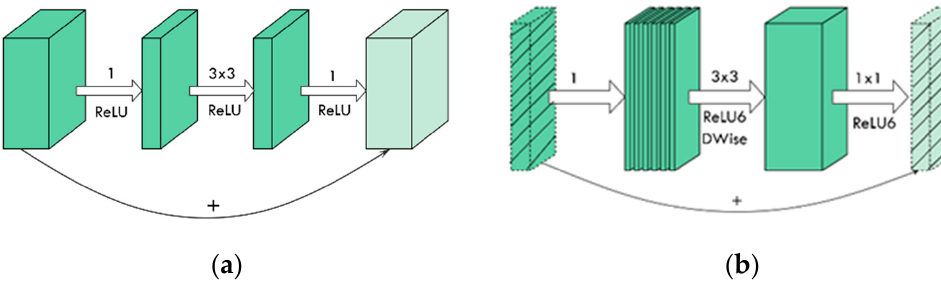
Figure 2. In ( a ), the residual is used to connect the layers with a high number of channels, whereas in ( b ) the bottlenecks are connected by inverted residuals [29].